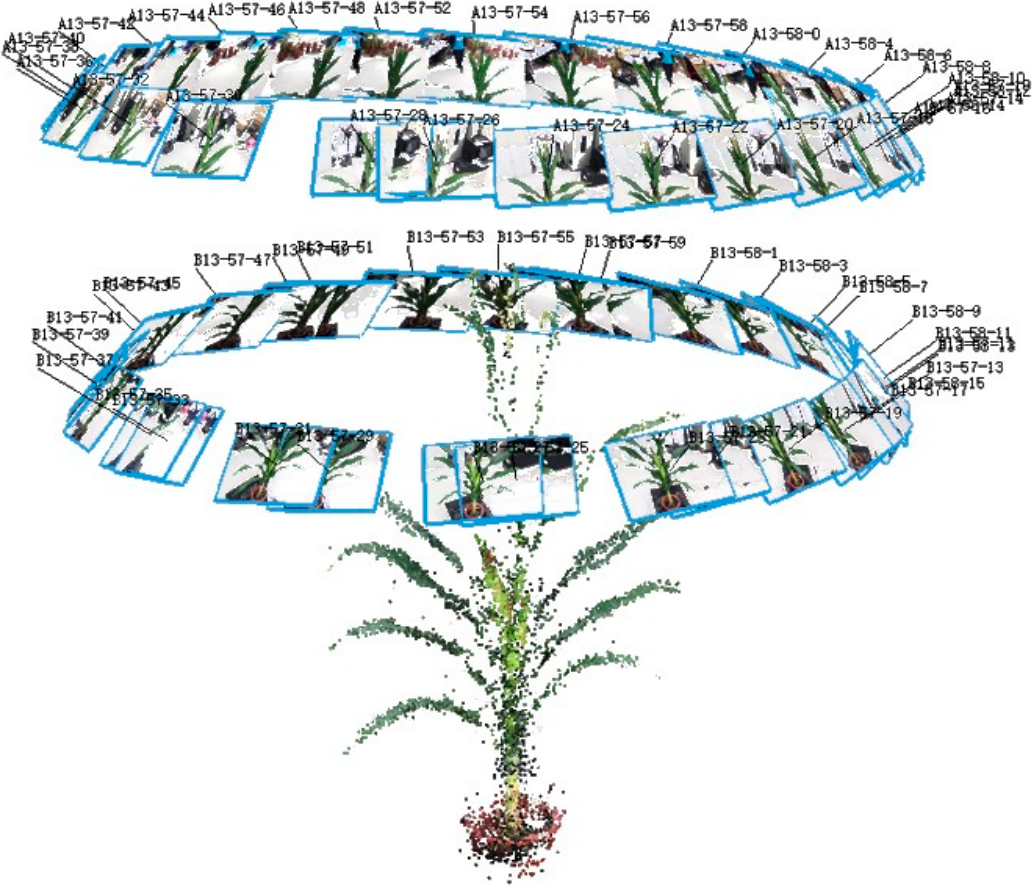
Figure 2. Diagram of MVS reconstruction using PhotoScan.